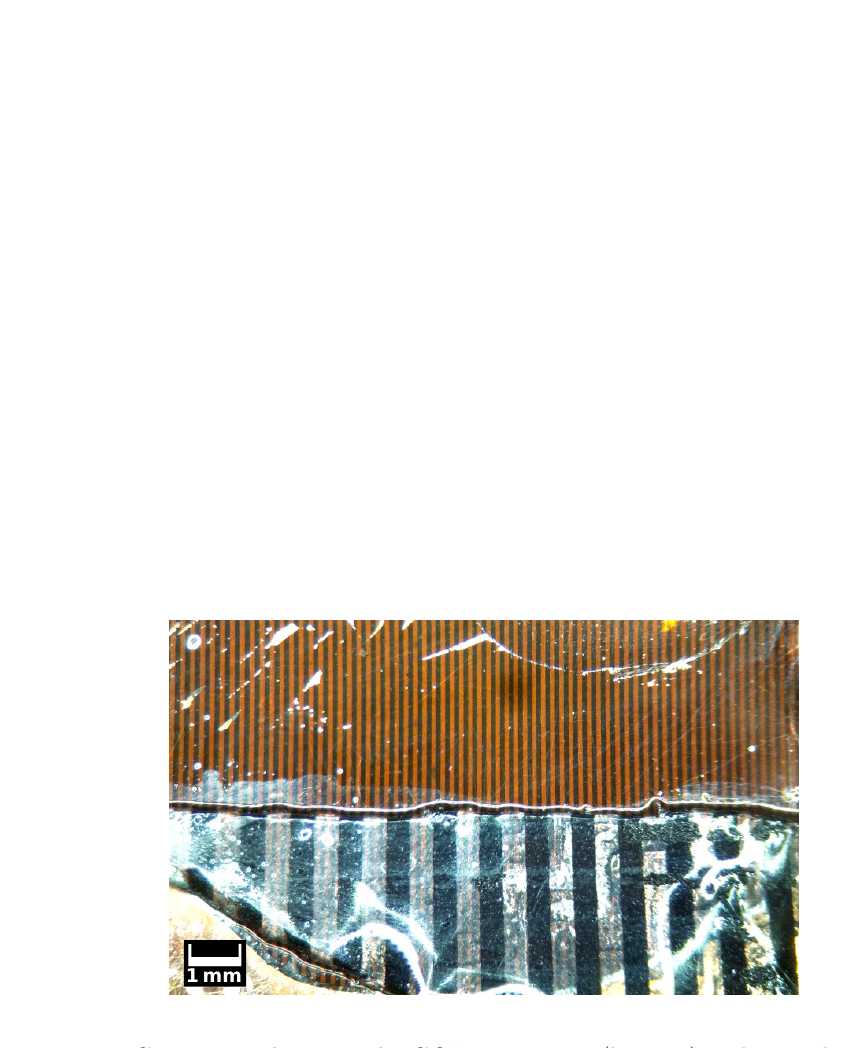
Figure 28: Comparison between the GORE structure (bottom) and our solution